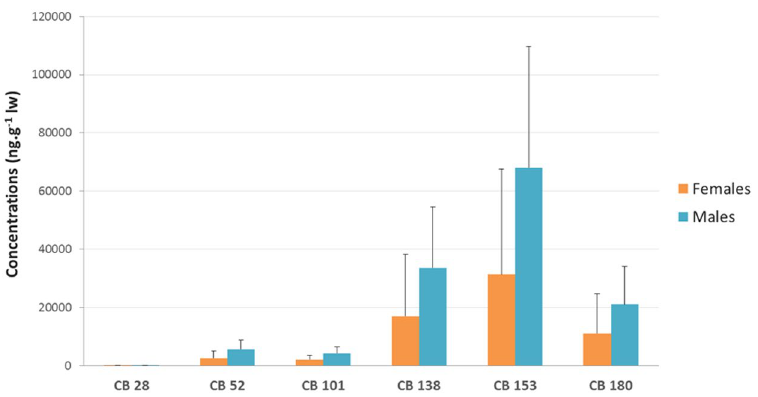
Figure 2. Mean concentrations (and standard deviation) of Σ 6 NDL-PCBs (ng.g − 1 lw) in blubber biopsies of bottlenose dolphins from Normanno-Breton Gulf.